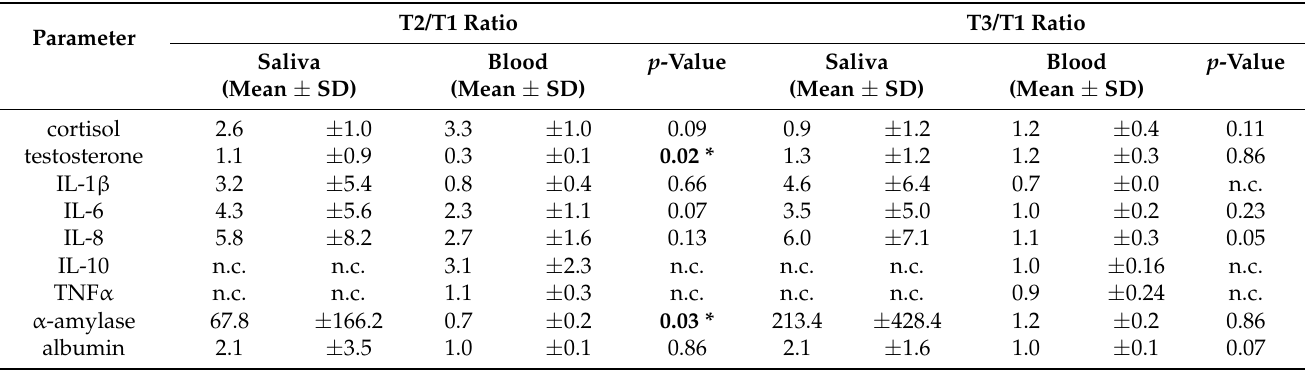
Table 4. Longitudinal change expressed as ratios of T2 and T3 to baseline of salivary and blood parameters. The p -values indicate the differences between saliva and blood calculated by Wilcoxon signed-rank test. Bold values and an asterisk mark the significant differences ( p <